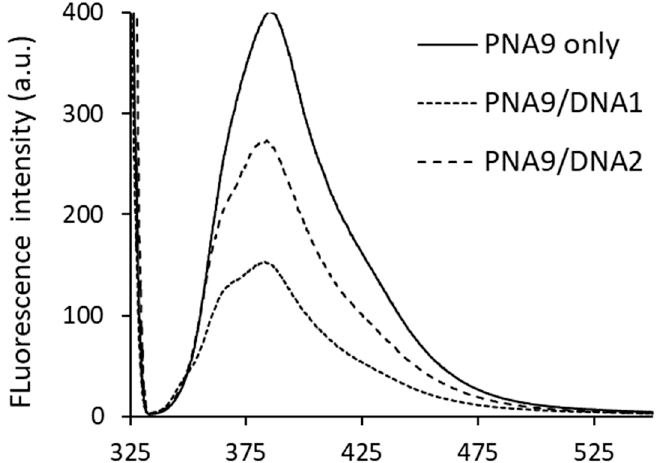
Figure 6. The fluorescence spectra of PNA 9 (solid), PNA 9 /DNA 1 (dashed-dotted line), and (dashed line) were measured in 20 mM sodium phosphate bu ff er (pH 7.4). Conditions: PNA, PNA 9 /DNA 2 (dashed line) were measured in 20 mM sodium phosphate buffer (pH 7.4). Conditions: DNA = 4 µ M, Excitation = 323 nm, Emission = 384 nm, Temperature = 25 ◦ PNA, DNA = 4 μ M, Excitation = 323 nm, Emission = 384 nm, Temperature = 25 ° C .